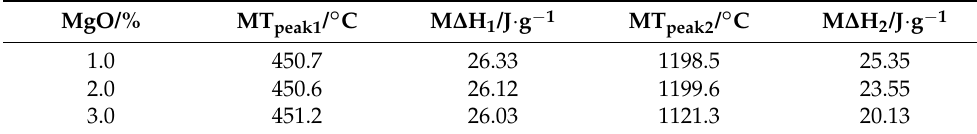
Figure 7. DSC curves of raw materials with different MgO contents. Table 3. Endothermic peak temperature and heat of materials with different MgO contents.